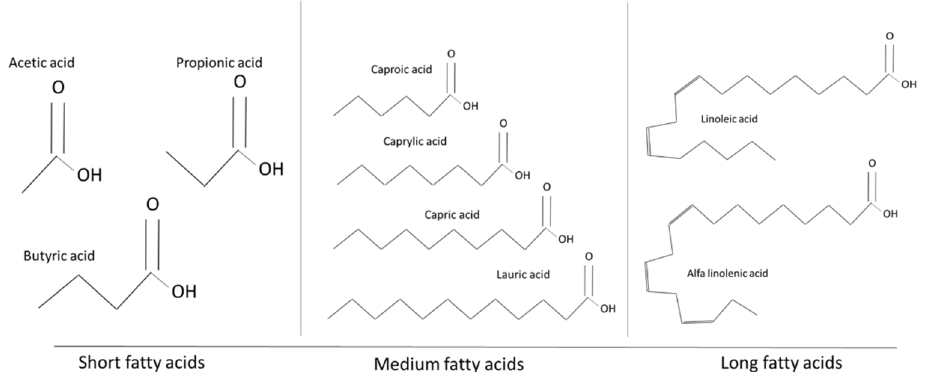
Figure 3. Examples of organic acids applied as antimicrobials.